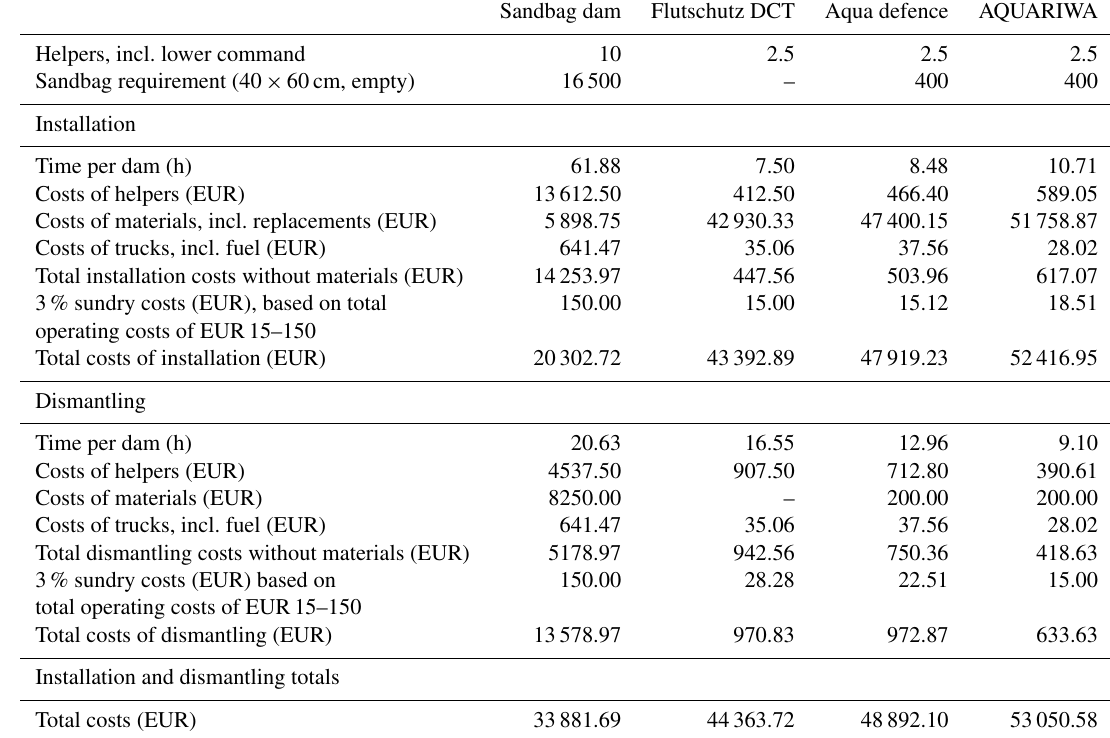
Table 5. Comparison of the costs of the installation and dismantling of sandbag systems and SBRSs – temporary flood dam, protection length 100m (case